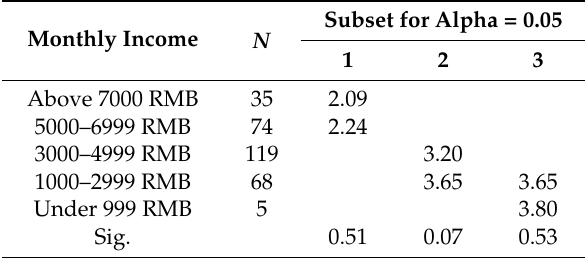
Table 7. Public’s subsidies expectations of different income levels.